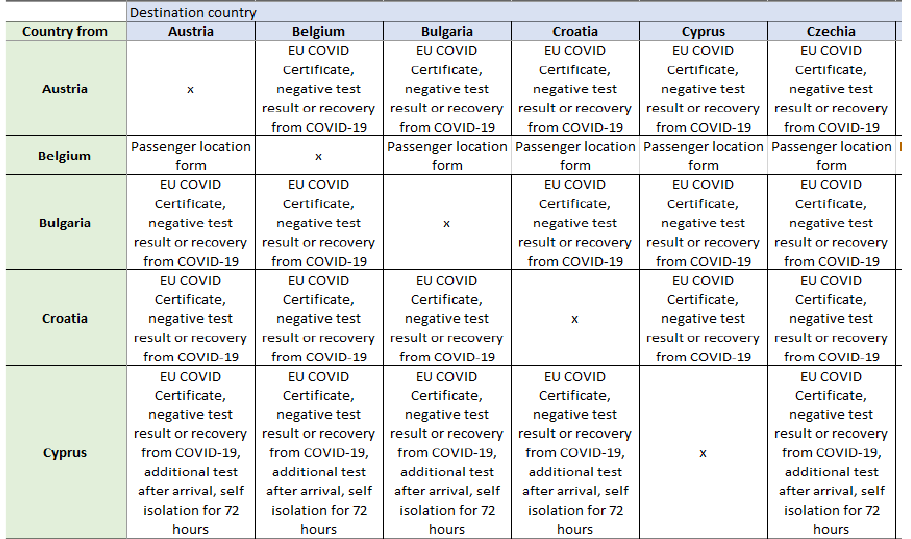
Figure 2. Example screenshot from the proposed dataset with restrictions in countries. Source: Authors own elaboration.